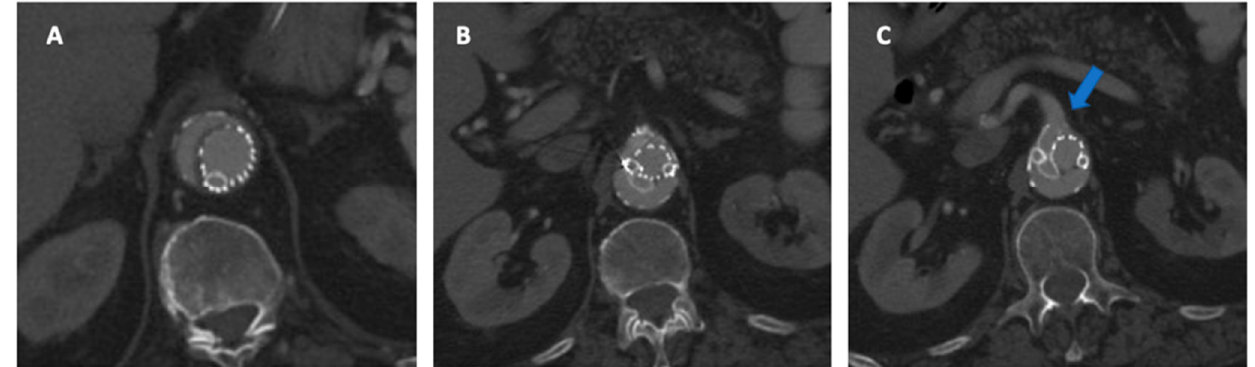
Figure 7. During this procedure, the branched endograft was positioned incorrectly (turned 180°). Note in ( A,B ) the posterior origin of the branches for celiac trunk and superior mesenteric artery, respectively. In ( C ), there is evidence of a type 1C endoleak due to an inadequate sealing zone in the superior mesenteric artery (blue